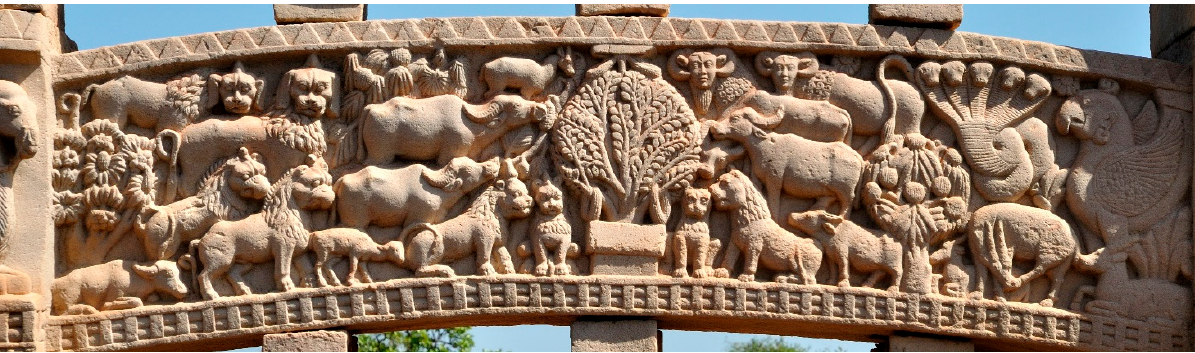
Figure 3. Multitude of animals gathered around the Buddha, represented as a Bodhi tree, in the classic style of ancient Buddhist aniconism. S ā ṃ c ī nagara, Madhya Prade ś . Photo by Biswarup Gan- sic style of ancient Buddhist aniconism. Sām cī nagara, Madhya Pradeś. Photo by Biswarup Ganguly, guly, CC BY 3.0 (Wikimedia Commons). ˙ CC BY 3.0 (Wikimedia